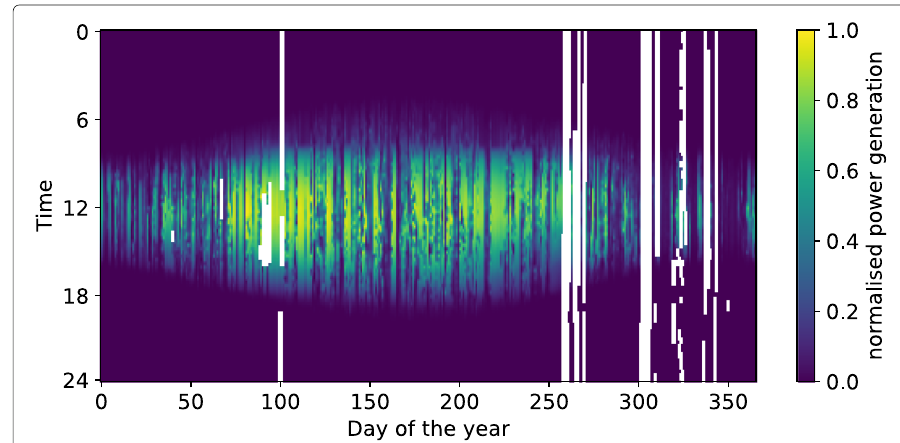
Fig. 2 Normalised power generation in 15 min (white represents missing data)